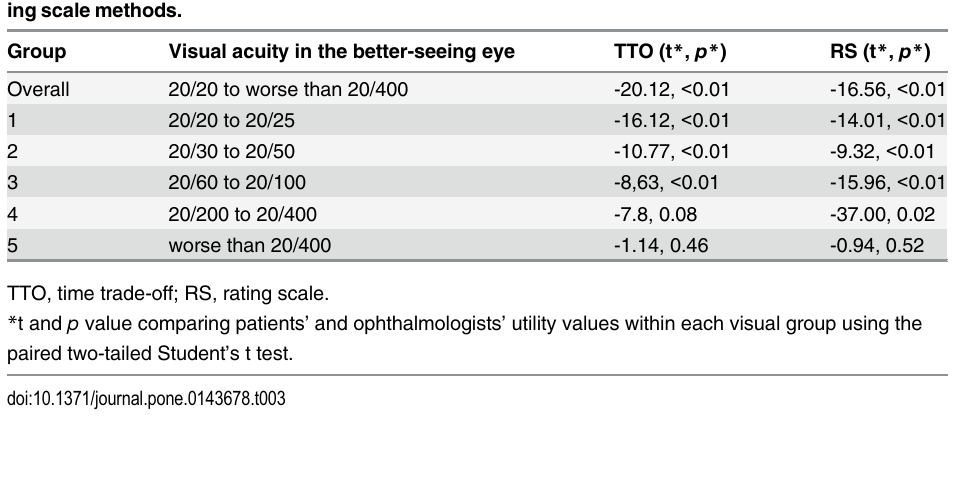
Table 3. Comparison of the patients ’ and ophthalmologists ’ utility values using time trade-off and rat- ing scale methods. Group Visual acuity in the better-seeing eye